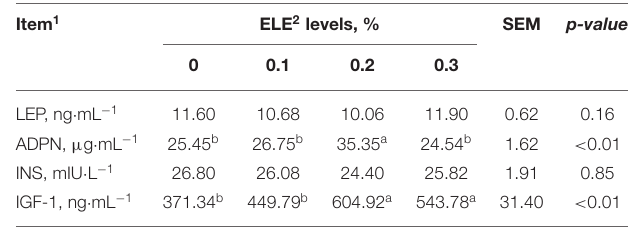
TABLE 4 | Carcass trait of growing–finishing pigs fed the diets with various levels of ELE.